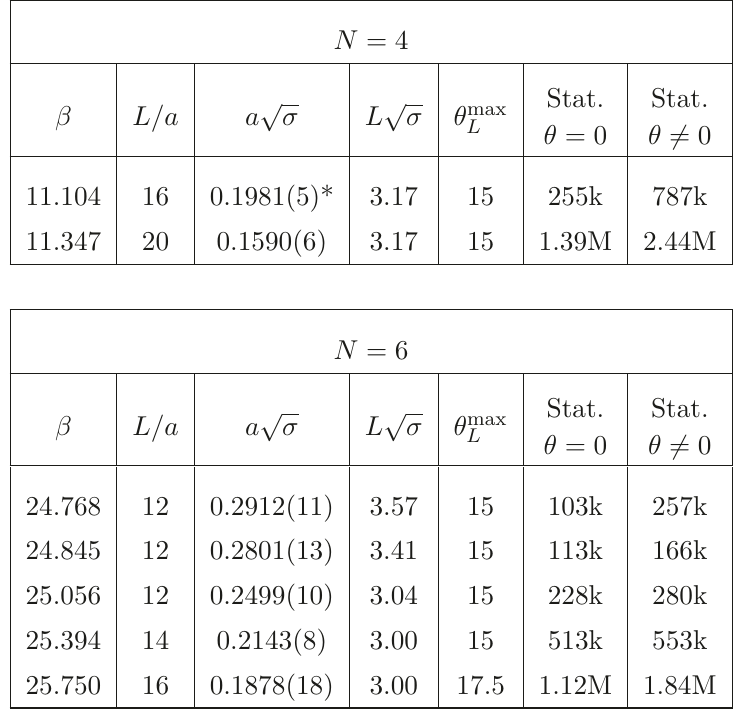
Table 1 . Summary of simulation parameters. Simulations at non-zero values of θ L were performed in steps of ∆ θ L = 2 up to θ L = 10 and in steps of ∆ θ L = 2 . 5 for θ L > 10. The last column refers to the total statistics accumulated for all imaginary- θ simulations. The defect length was, in all cases, L d /a = 2. All simulations for N = 4 were performed using N r = 10, corresponding to a constant swap probability p around 20%, while simulations for N = 6 used N r = 17, corresponding to p 30%. Lattice spacings are taken from ref. [70] or interpolation/extrapolation of data thereof, ≈ except for the one marked with *, which comes from ref.